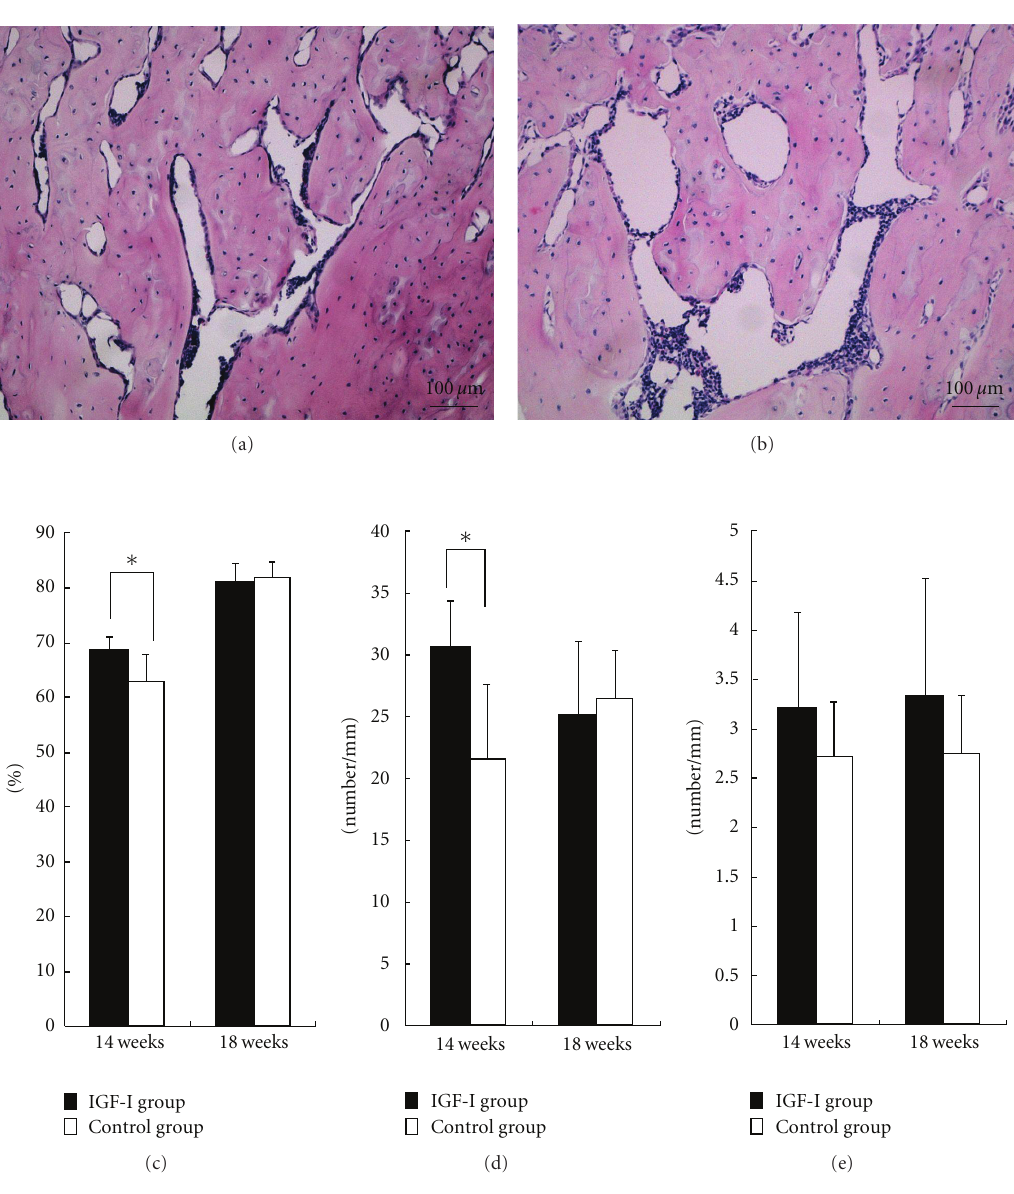
Figure 8: (a, b) Coronal sections of bone matrix in the mandibular condyle in the IGF-I group (a) and the control group (b) at 14 weeks of age (hematoxylin-eosin staining, 100x magnification, bars = 100 μ m). (c–e) Bone matrix ratio (c), number of osteoblasts (d), and number of osteoclasts (e). Data represent the mean ± SD of six rats ( ∗ P < 0 . 05 versus control), adapted from a previous report